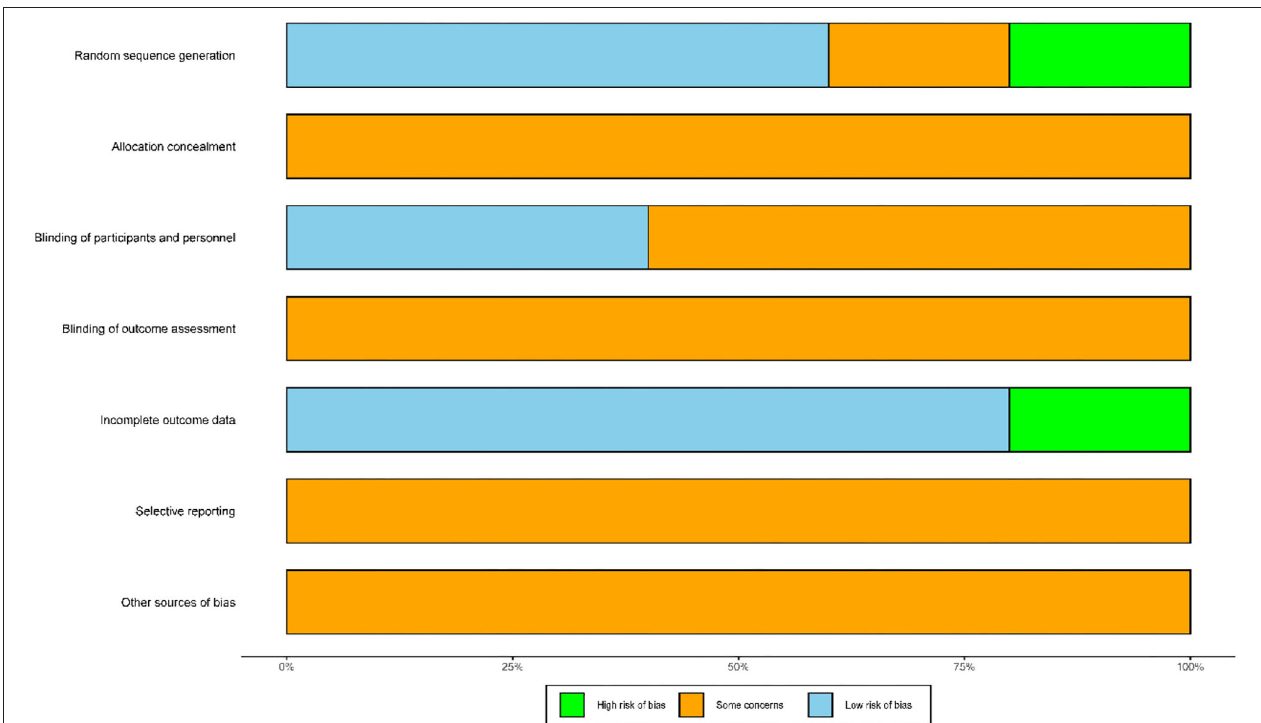
FIGURE 2 | Risk of bias